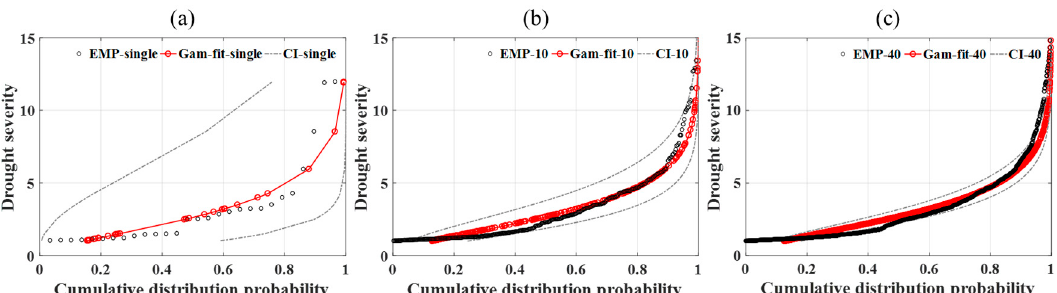
Figure 4. Illustration of frequency analysis for drought severity under the empirical distribution (EMP, the dark circle) and the gamma distribution (Gam-fit, the red circle). The dashed grey line shows the 95% confidence intervals (CI) of the gamma distribution in parameter estimation. ( a ) The cumulative distributions based on one-member simulation of CESM1; ( b )The cumulative distributions based on 10-member simulations of CESM1; ( c )The cumulative distributions based on 40-member simulations of CESM1 .